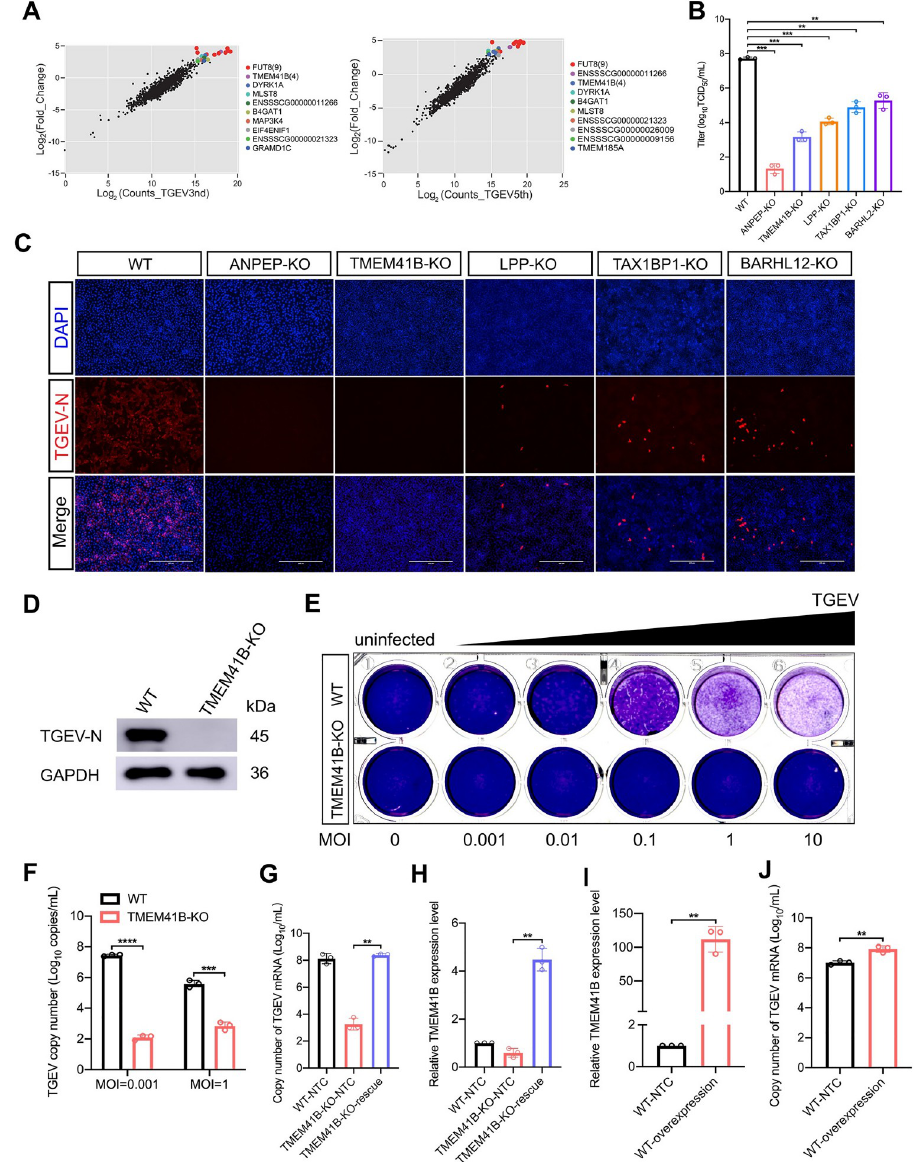
Fig 2. TMEM41B is a host factor required for TGEV replication. (A) Verification of candidate genes enriched in the genome-wide CRISPR screen using a second, focused-CRISPR library screen. Scatter plots compare sgRNA targeted sequence frequencies and the extent of enrichment in the transformed PK-15-Cas9 cells (mock-treated versus TGEV infected) for the third (TGEV3rd) and fifth (TGEV5th) rounds of TGEV screening. Counts_TGEV3rd and Counts_TGEV5th represent the average values of the read counts from paired-end sequencing. Log2(fold change) is the median log 2 ratio between normalized sgRNA count of TGEV challenged and mock-treated cell populations. (B) Quantification of virus infectivity (TCID 50 ) in culture supernatant collected 24 hpi from TGEV-infected (MOI = 0.1) WT and KO ( ANPEP , TMEM41B , LPP , TAX1BP1 , BARHL12 ) cell lines. (C) Immunofluorescence assays for detection of the TGEV N protein in WT cells and five selected genes ( ANPEP , TMEM41B , LPP , TAX1BP1 , BARHL12 ) KO cells following infection with TGEV (MOI = 0.1) at 24 hpi. Scale bar, 200 μ m. (D) Western blot assay to detect the TGEV N protein expressed in TMEM41B KO and WT cells following infection with TGEV (MOI = 1) at 24 hpi. GAPDH used as an internal control gene. (E) Viral quantification by plaque assays. TMEM41B KO and WT cells were seeded into 24-well culture plates and infected with TGEV at different MOIs (0, 0.001, 0.01, 0.1, 1 and 10). Plates stained with 1% crystal violet to view plaques. (F) TMEM41B KO and WT cells were infected with TGEV at different MOIs (0.001 and 1), TGEV N copy number was assessed by absolute quantitative real-time PCR. (G and H) Rescue assays for WT, TMEM41B-KO and TMEM41B-KO-rescue cells infected with TGEV (MOI = 1). RT-qPCR assay for determination of (G) relative mRNA level of TMEM41B and (H) absolute mRNA level of TGEV N gene. TMEM41B-KO-rescue: